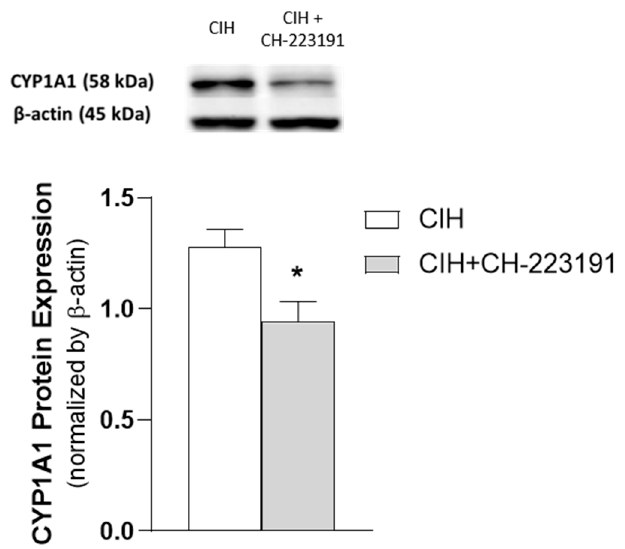
Figure 4. Effect of CH-223191 in CYP1A1 protein expression in renal cortex tissue of CIH-exposed rats (35 days). CYP1A1 protein levels were quantified in the renal cortex of CIH-exposed rats administered with CH-223191 ( n = 5) or vegetable oil (CIH) ( n = 6). Mann–Whitney’s U-test; comparison CIH vs. CIH + CH-223191: * p < 0.05. CYP1A1: cytochrome P450 family 1, subfamily A, polypeptide 1.